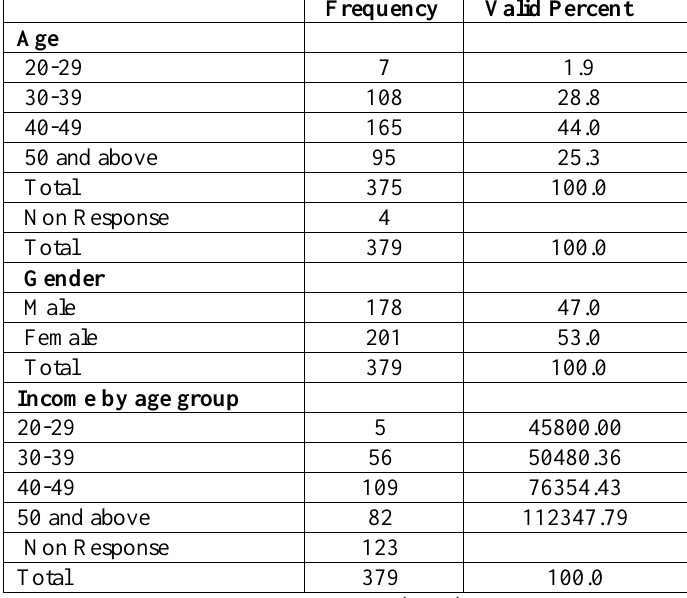
Table 1: Respondents’